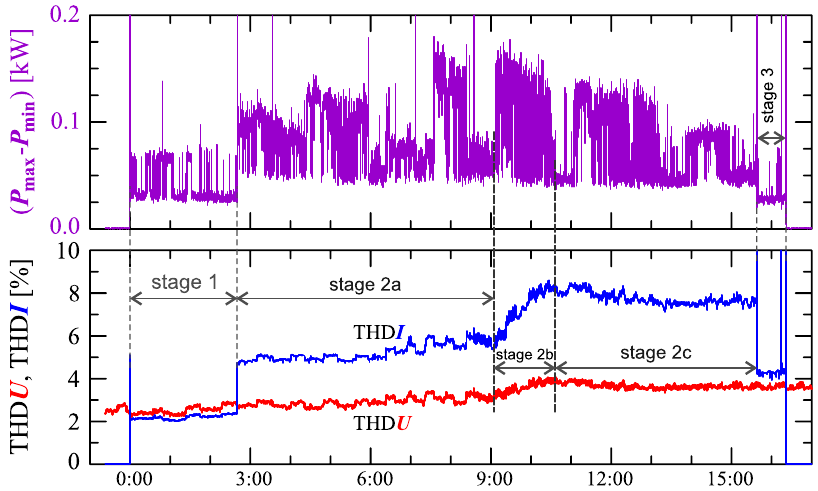
Figure 36. The characteristic of difference between the maximum and minimum active power ( P max − P ) = f ( t ) (top), and the characteristic of the voltage THD factor THD U = f ( t ) and current min THD factor THD I = f ( t ) (bottom) for Case V.